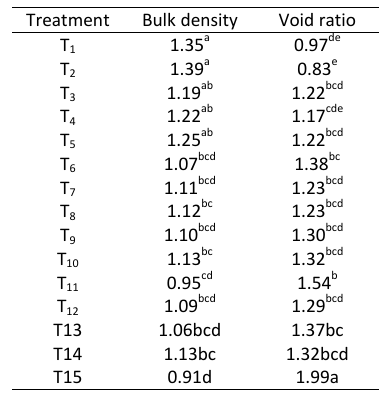
Table 8: Comparison of means of dill yields under different Table 8. Comparison of means of dill yields under different treatments Treatment